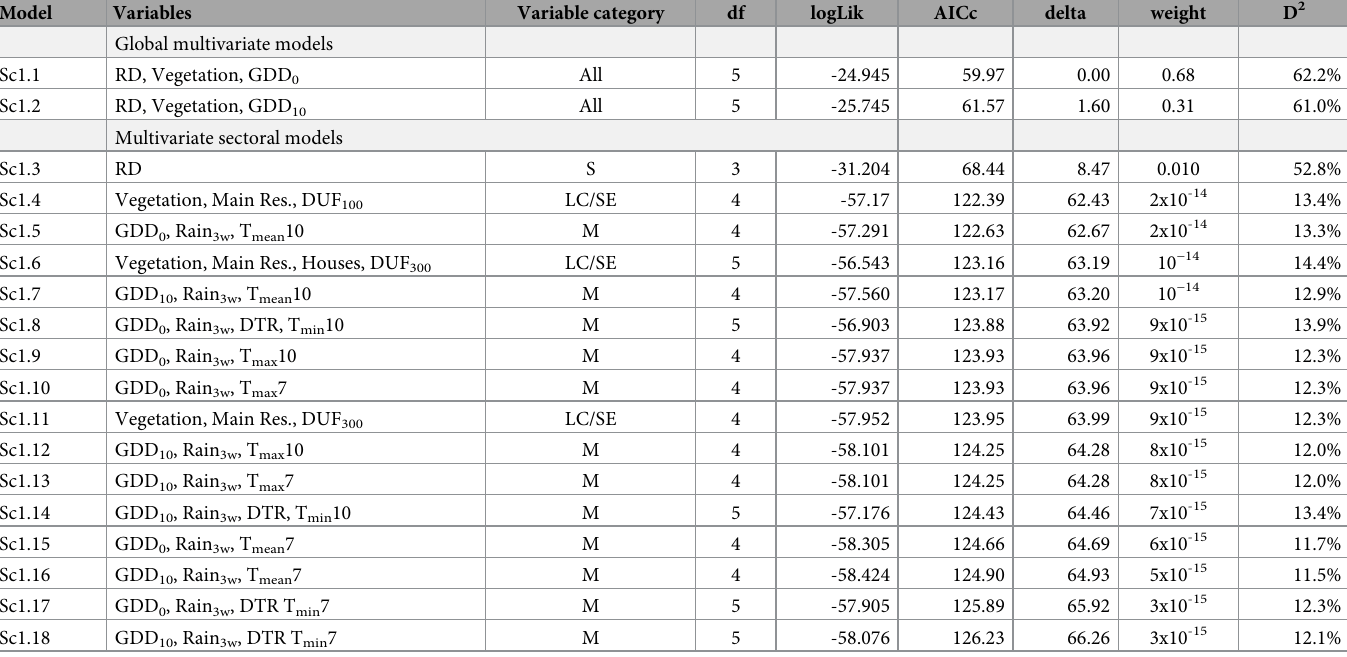
Table 5. Results of binomial regression of emergence of autochthonous arbovirus infections for scenario Sc1 (place of transmission at the residence of the autoch- thonous case). Model Variables